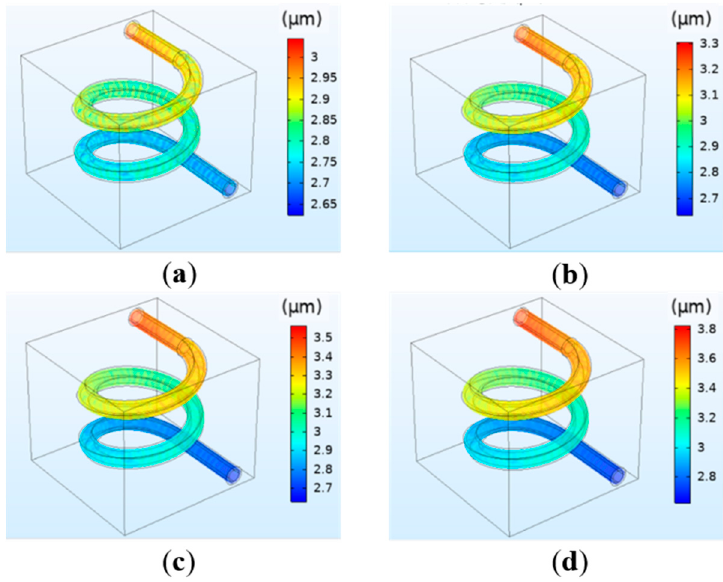
Figure 5. Simulation results of the vessel deformation under di ff erent perfusion pressure: ( a ) 12 mmHg; ( b ) 13 mmHg; ( c ) 14 mmHg; ( d ) 15 mmHg.